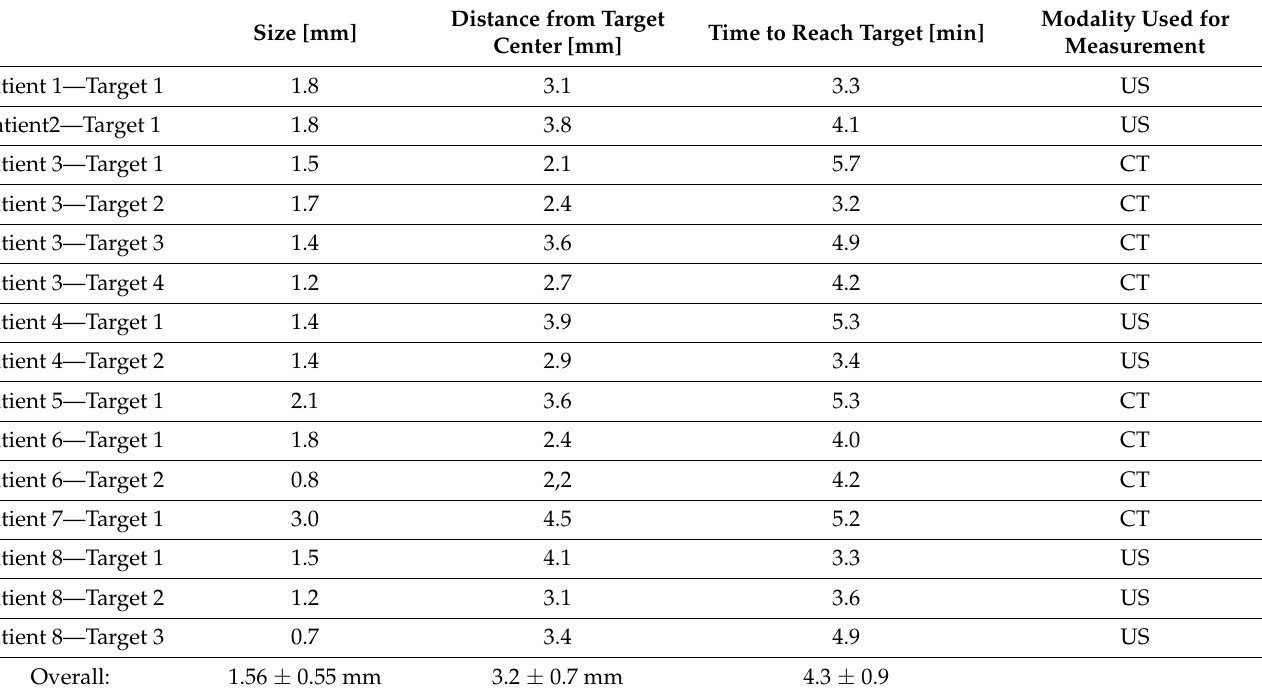
Table 1. Sizes of the targets, the distance of the interventional device tip from the center of each target tumor, the time needed to reach the target, and the modality used for the distance measurement. Distance from Target Modality Used for Size [mm] Time to Reach Target [min] Center [mm]